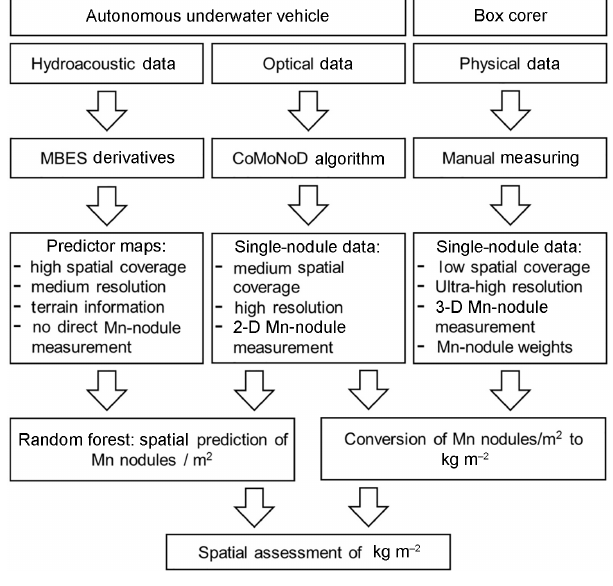
Figure 1. Schematic workflow of the data sets used in this study to enable the spatial assessment of Mn nodules inside the study area. The medium resolution of AUV MBES (meter scale) refers to the comparison of the optical and physical data (centimeter